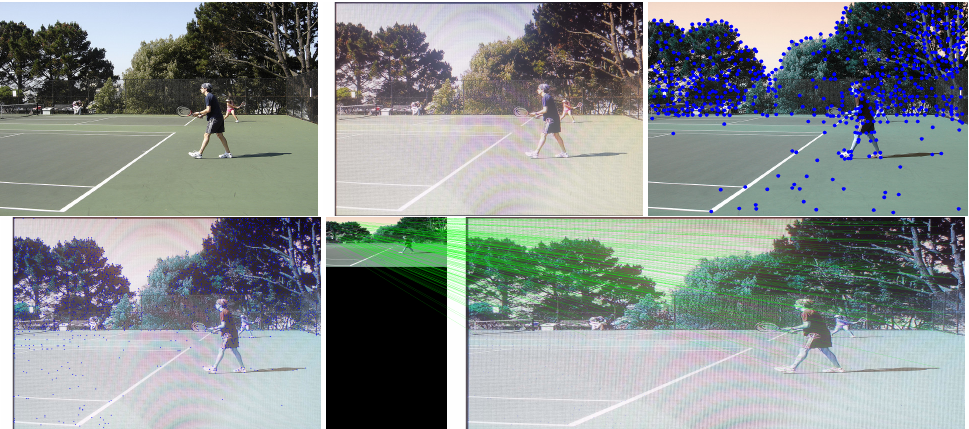
Figure 15. ( Moire ) Row 1: Left (original image), Middle (attacked images.), Right (resulting point of original image by SuperPoint’s detector). Row 2: Left (resulting point of attacked image by SuperPoint’s detector), Right (the green lines show the correct correspondences after blurring attacks).